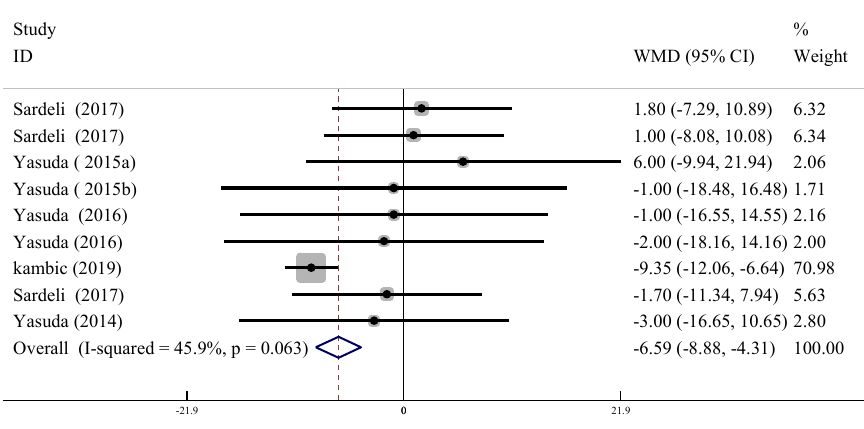
Figure 8. Forest plot of the effect of LL-BFR training on resting SBP.